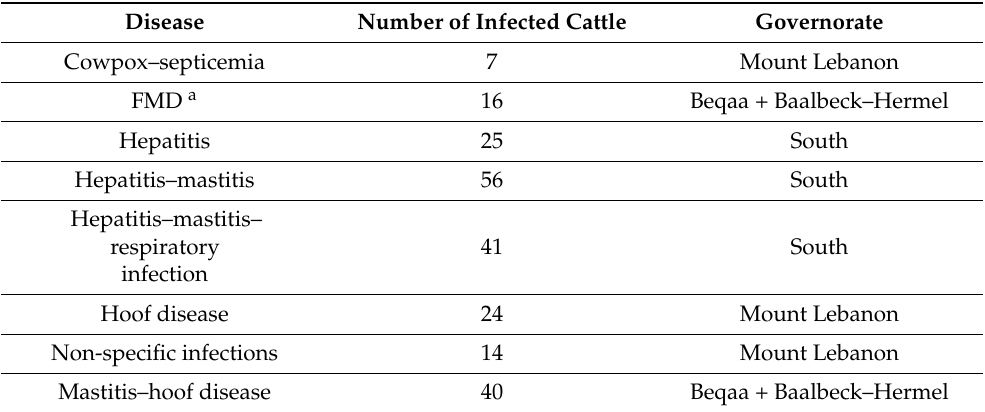
Table 3. Distribution of cattle diseases across the Lebanese governorates. Disease Number of Infected